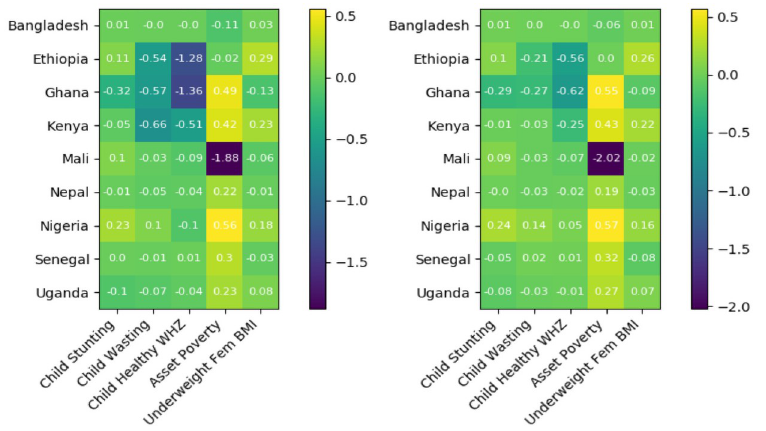
Fig 1. r 2 for sequential poverty and malnutrition prevalence nowcasting indexed by country. (Left) Independent RF (Right) MRF. Scores are computed by pooling predictions across all surveys within each country, with shared testing and training folds used across all models.